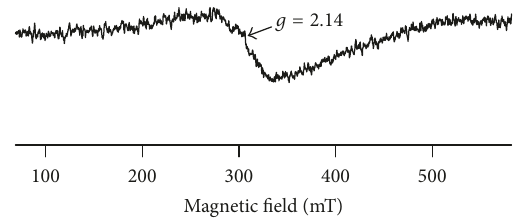
Figure 5: ESR spectra at 300 K of powdered sample of 1 .